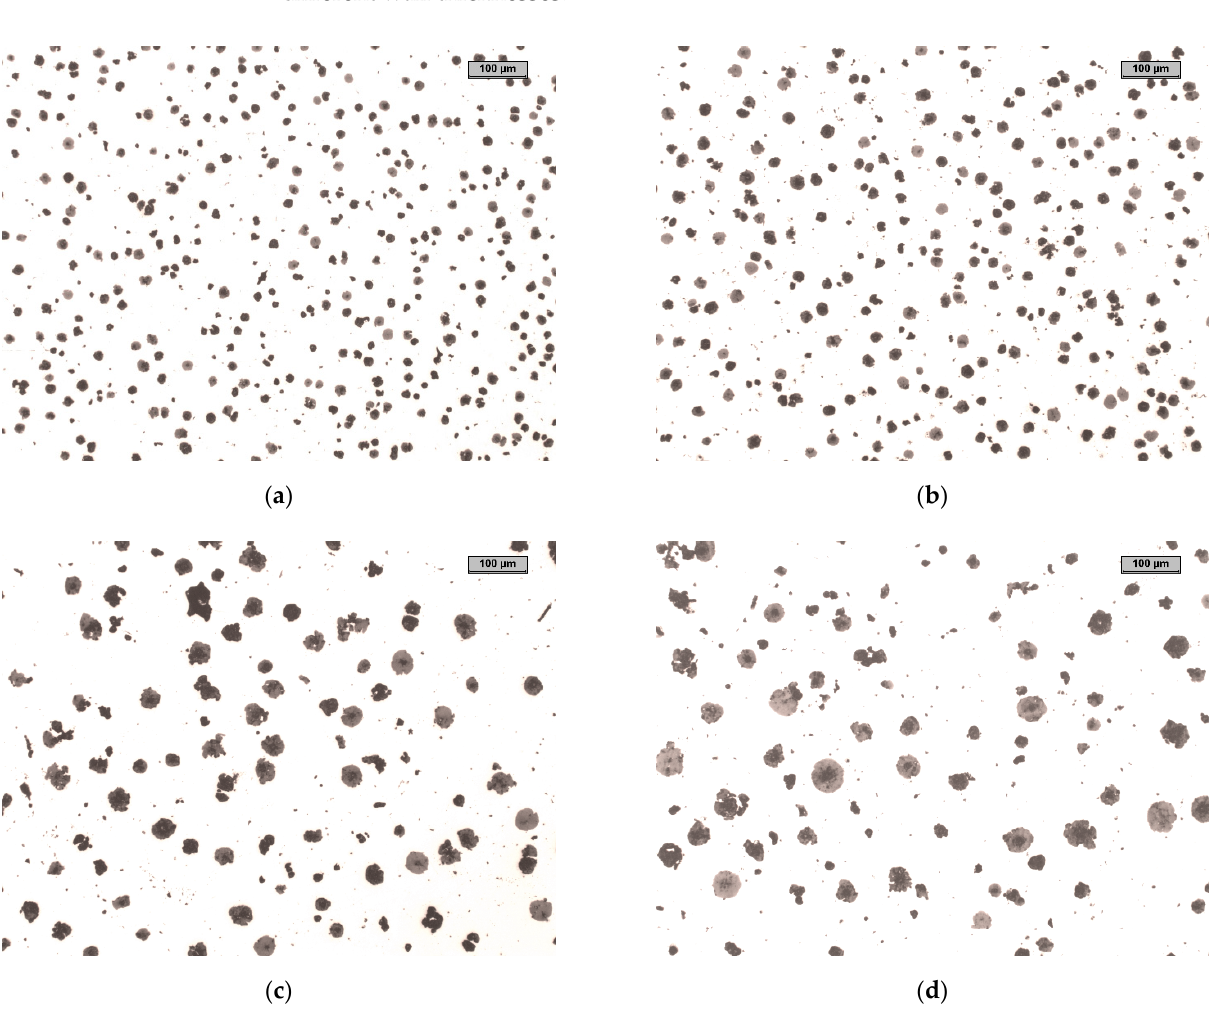
Figure 4. Microstructure of Si–Mo ductile iron in castings with different wall thicknesses: ( a ) 3 mm; ( b ) 5 mm; ( c ) 13 mm; and ( d ) 25 mm. No etched samples.